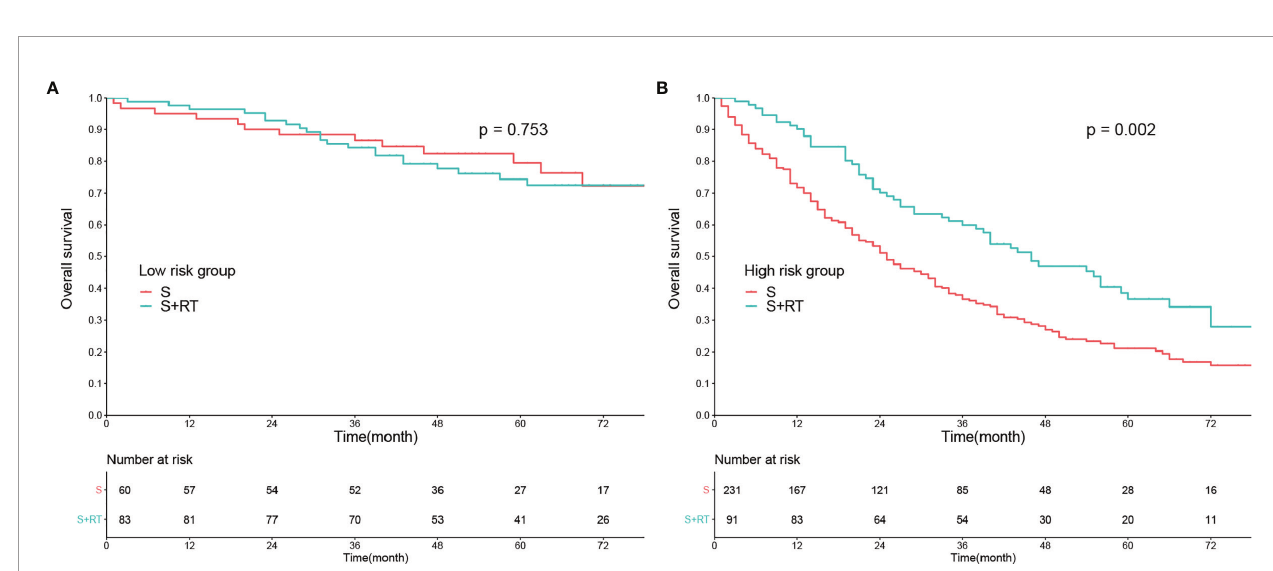
FIGURE 4 | The effect of postoperative radiotherapy (RT) on overall survival of rectal cancer patients with tumor deposits. Kaplan – Meier curves in the high-risk group (A) and low-risk group (B) . S,